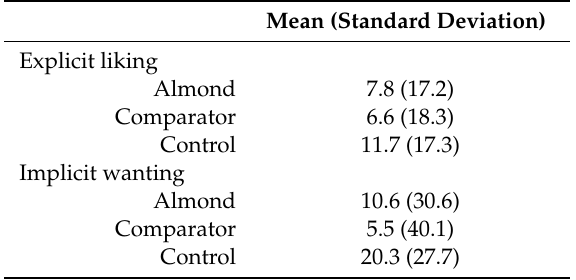
Table 3. Mean (SD) explicit liking and implicit wanting fat appeal bias for the different snack conditions.